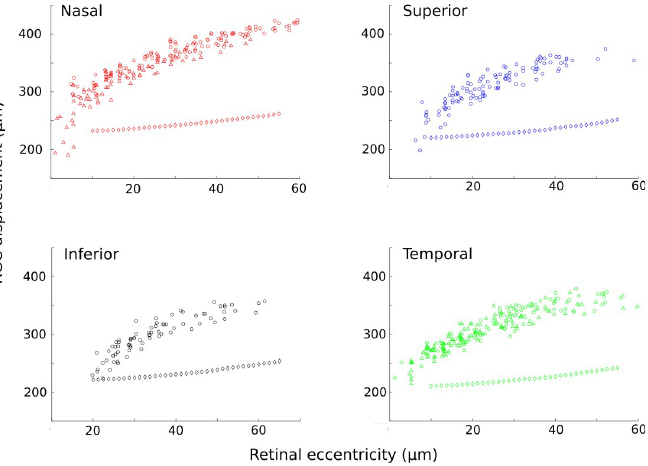
Fig 7. Comparison of measured and predicted RGC displacements as a function of receptive field eccentricity for each of the 4 quadrants of the foveola. Triangles represent data taken at a superficial focus, circles represent data taken at the deeper focal position (see online methods). Diamonds represent predicted RGC displacements based on a geometrical model for cone pedicle displacement proposed by Schein [7].